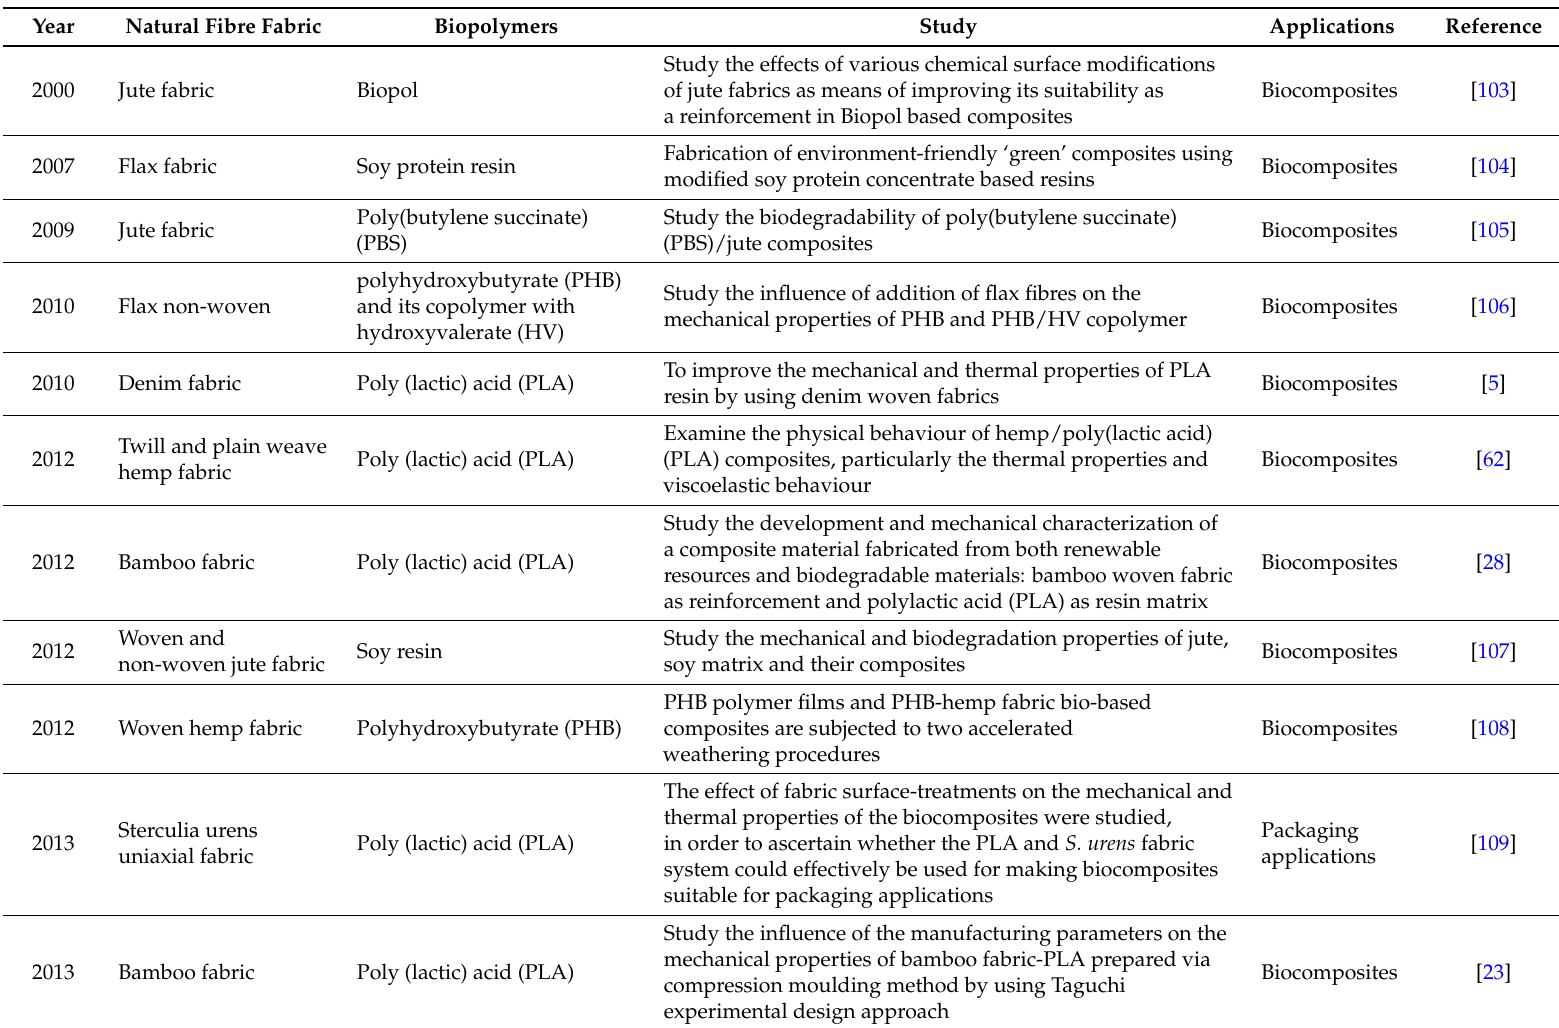
Table 6. Chronological order of events in the exploration of natural fibre fabric-biopolymer composites and their related